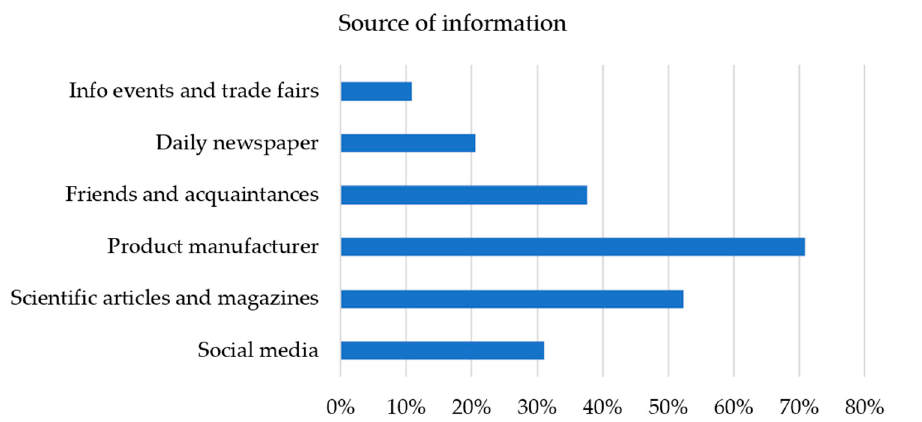
Figure 8. Source of information for sustainability assessment in purchasing decisions.